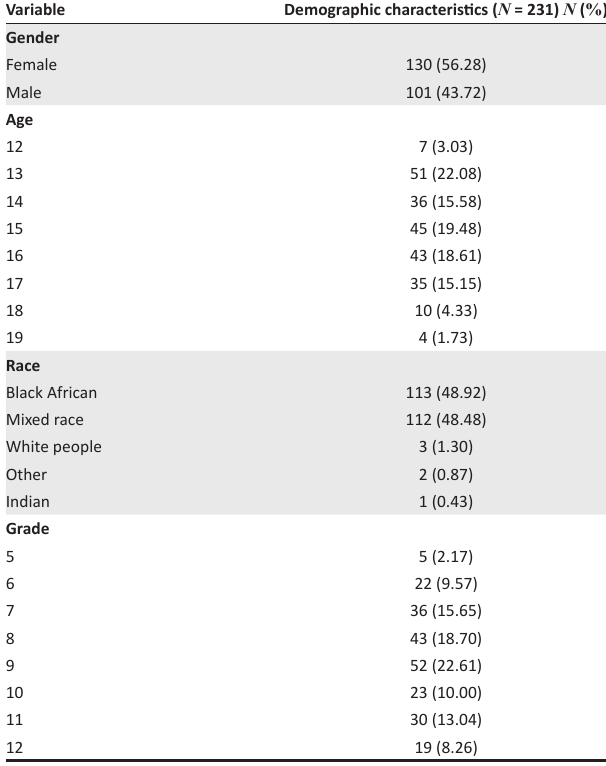
TABLE 1: Demographic characteristics of